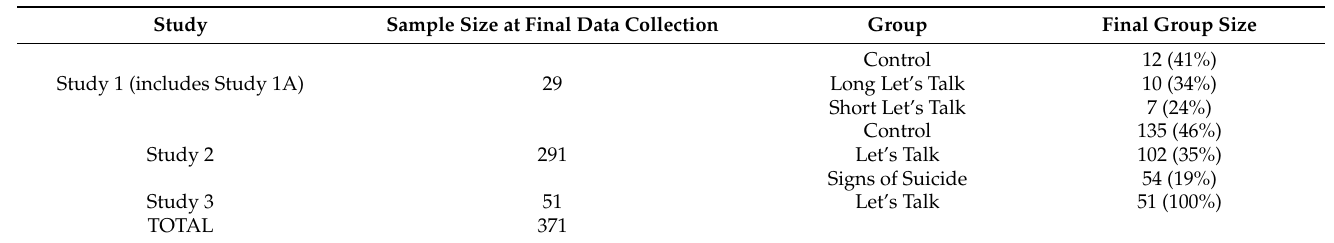
Table 1. Enrollment for all studies.